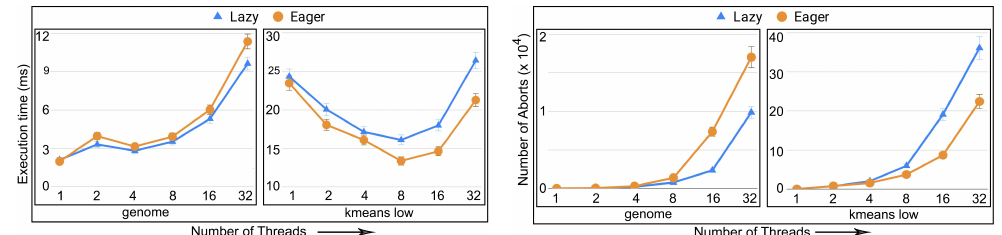
Figure 3. An illustration of performance discrepancies in execution time ( left ) and number of aborts ( right ) in genome and kmeans benchmarks using eager and lazy versioning in non-persistent TM